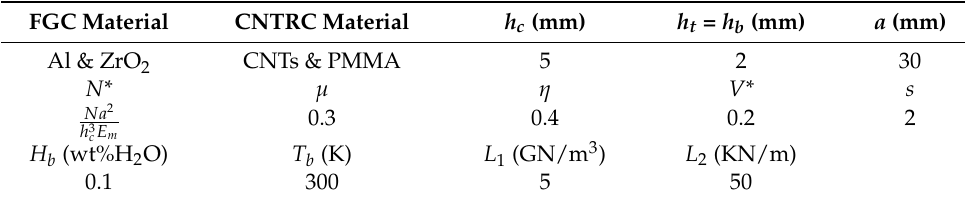
Table 5. Fundamental details of the